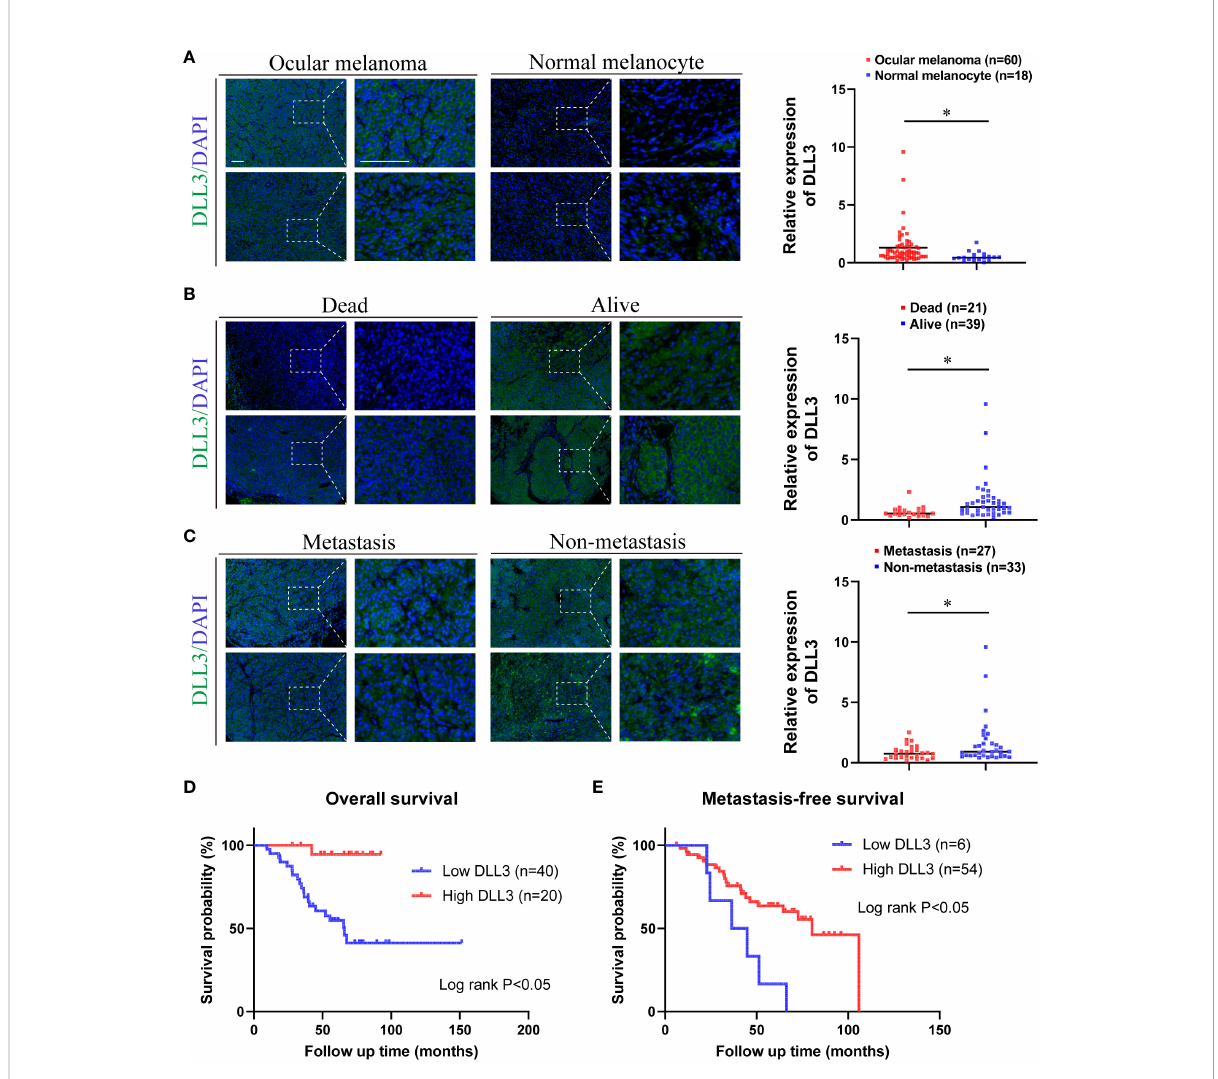
FIGURE 6 Ocular melanoma biospecimens were used to validate the aberrant expression and prognostic value of DLL3. (A) Representative immuno fl uorescence staining of DLL3 in ocular melanoma and normal melanocyte (left). Quanti fi ed data for DLL3 staining showed that the expression level of DLL3 in ocular melanoma samples was signi fi cantly high than that in normal melanocyte tissues (right). (B) Representative immuno fl uorescence staining of DLL3 in ocular melanoma samples from patients with different living statuses (left). Quanti fi ed data for DLL3 staining showed that the expression level of DLL3 in alive patients was signi fi cantly higher than that in patients who died during the follow-up (right). (C) Representative immuno fl uorescence staining of DLL3 in ocular melanoma patients with or without the metastasis occurrence (left). Quanti fi ed data for DLL3 staining showed that the expression level of DLL3 was higher in non-metastatic samples than that in metastatic ones (right). (D, E) Kaplan-Meier curves showed that high DLL3 expression signi fi cantly prolonged the overall survival (D) and metastasis-free survival (E) of patients with ocular melanoma. Scale bar = 50 m m. * P <